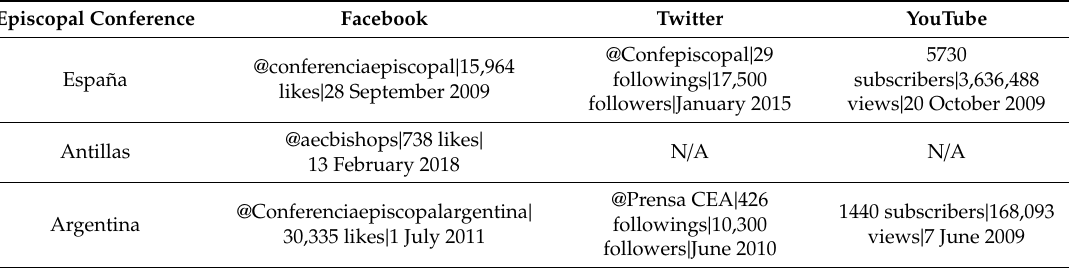
Table 7. Comparison of the CEE on YouTube with the Latin American Episcopal